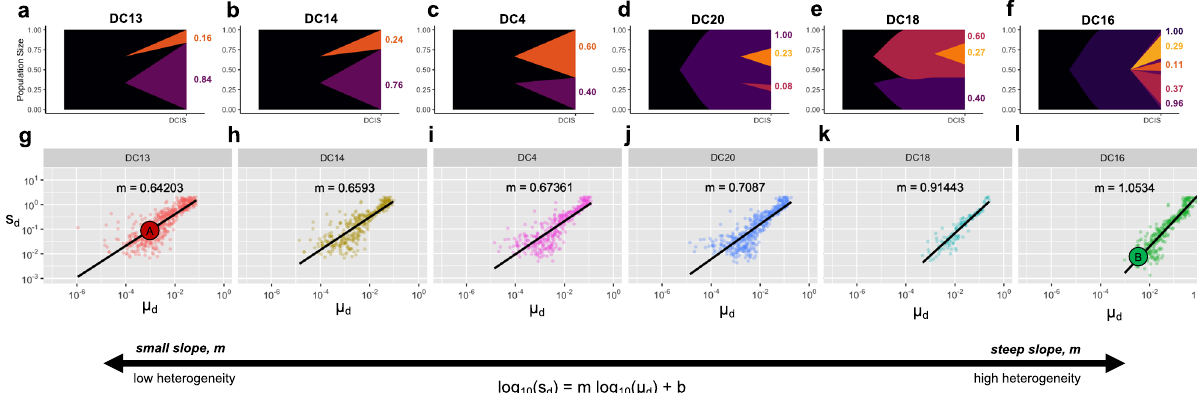
Fig. 3 Model parameterization of DCIS heterogeneity. a – f Muller diagrams of inferred clonal heterogeneity of the six polyclonal synchronous DCIS-IDC patients from Casasent et al. 20 , arranged from low ( a ) to high ( f ) heterogeneity. g – l The mathematical model is extended to a three-dimensional domain and constrained to grow inside a ductal network (Fig. 4a) and 10,000 stochastic simulations for a range of driver mutation rates ( μ d ∈ [10 − 7 , 1]) and fi tness ( s d ∈ [10 − 3 , 10]) are simulated to N = 10 4 cells. Parameterizations for which clonal diversity of the mathematical model (eqn. (3)) lie within error bounds reported in Casasent et al. are plotted and fi t to eqn. (4). As heterogeneity increases in a – f , the slope of this best fi t ( m ) also increases in g – l . Source data for a – f are provided as a Source Data fi